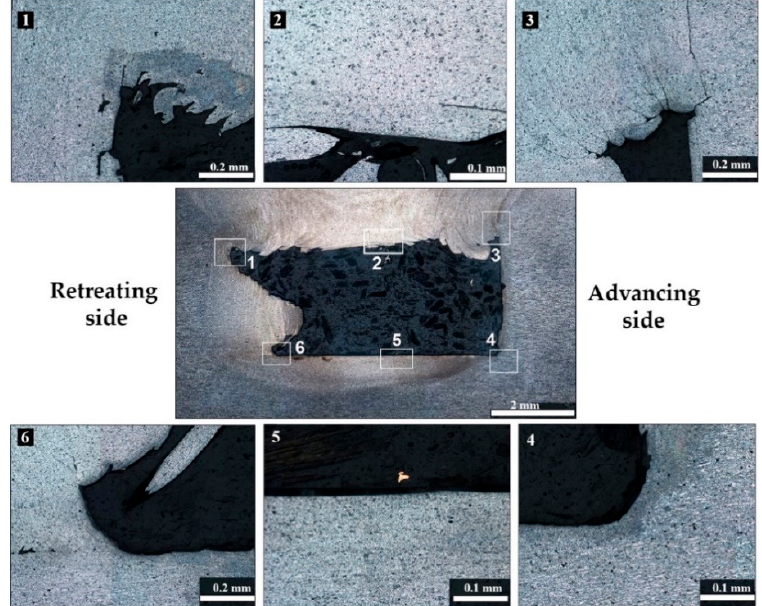
Figure 4. Macrograph of the cross-section of the channel with the identification of metallurgical zones of interest: 1—top corner of retreating side, 2—middle part of the ceiling, 3—top corner of the advancing side, 4—bottom corner of the advancing side, 5—middle part of the bottom and 6- bottom corner of the retreating side.